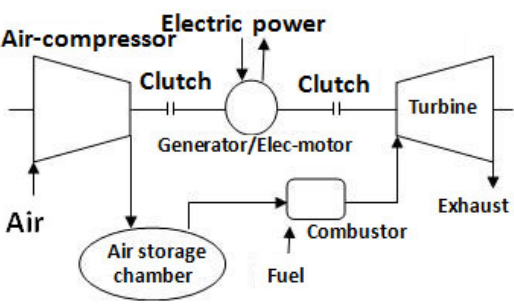
Figure 2. Compressed air energy storage (CAES) power generation